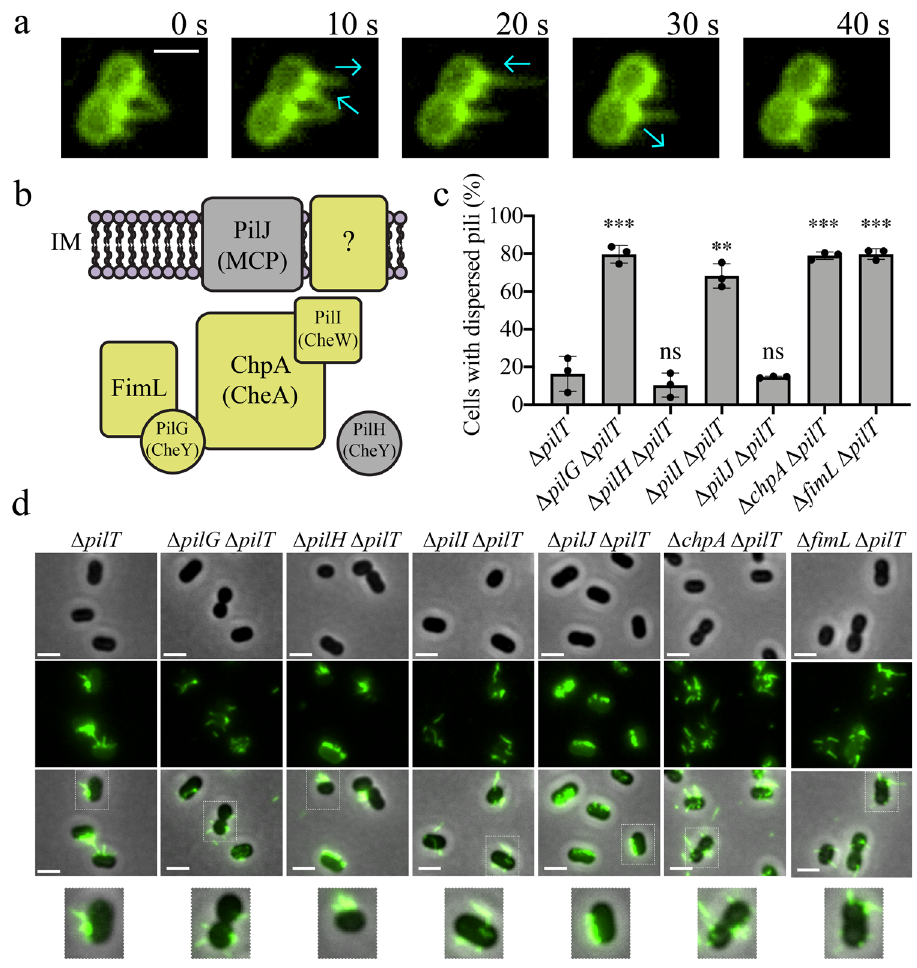
Fig. 1 | Acinetobacter baylyi localizes its T4P in a line along the long axis of the cell dependent onthePil-Chp pathway. a Representative time-lapse imagesof A. baylyi extending and retracting fl uorescently labeled T4P with background fl uor- escence subtracted. Blue arrows indicate direction of T4P movement. Scale bar, 1 µ m. b Schematic of the Pil-Chp components found in A. baylyi with analogous fl agellar chemotaxis protein names in parentheses. Deletions of components coloredgoldcausedispersedT4Plocalizationwhiledeletionofcomponentsingray have no effect on localization of T4P. IM, inner membrane. c Quanti fi cation of the percentage of cells in a population with dispersed T4P. Cells with dispersed T4P werede fi nedascellsthathadT4Ponmultiplesidesofthecellbody.Eachdatapoint represents an independent, biological replicate and bar graphs indicate the